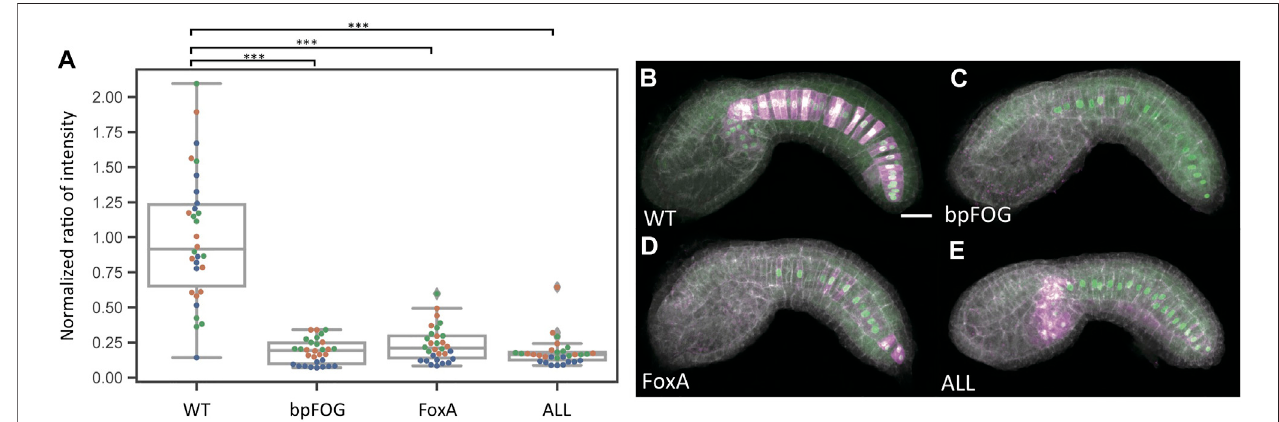
FIGURE 3 | Baseline determination. (A) Normalized reporter expression for an empty vector containing only the bpFOG basal promoter and the two most severe mutant constructs. Each datapoint represents a different imaged embryo. Each color indicates embryos from the same replicate. The box plots indicate the outlier- adjusted minimum, 1st quartile, median, 3rd quartile and outlier-adjusted maximum for each construct. Outliers are marked as lozenges. Asterisks indicate differential reporter expression between the empty or mutant construct and the wildtype construct. *** p < 0.001. (B – E) Representative sum-projected confocal images. (B) , wild type. (C) , empty construct containing only the bpFOG basal promoter. (D) , FoxA. E, ALL. Magenta: YFP reporter expression. Green: Bra > H2B:HA internal control expression. Gray: phalloidin. Scale bar: 20 µm.